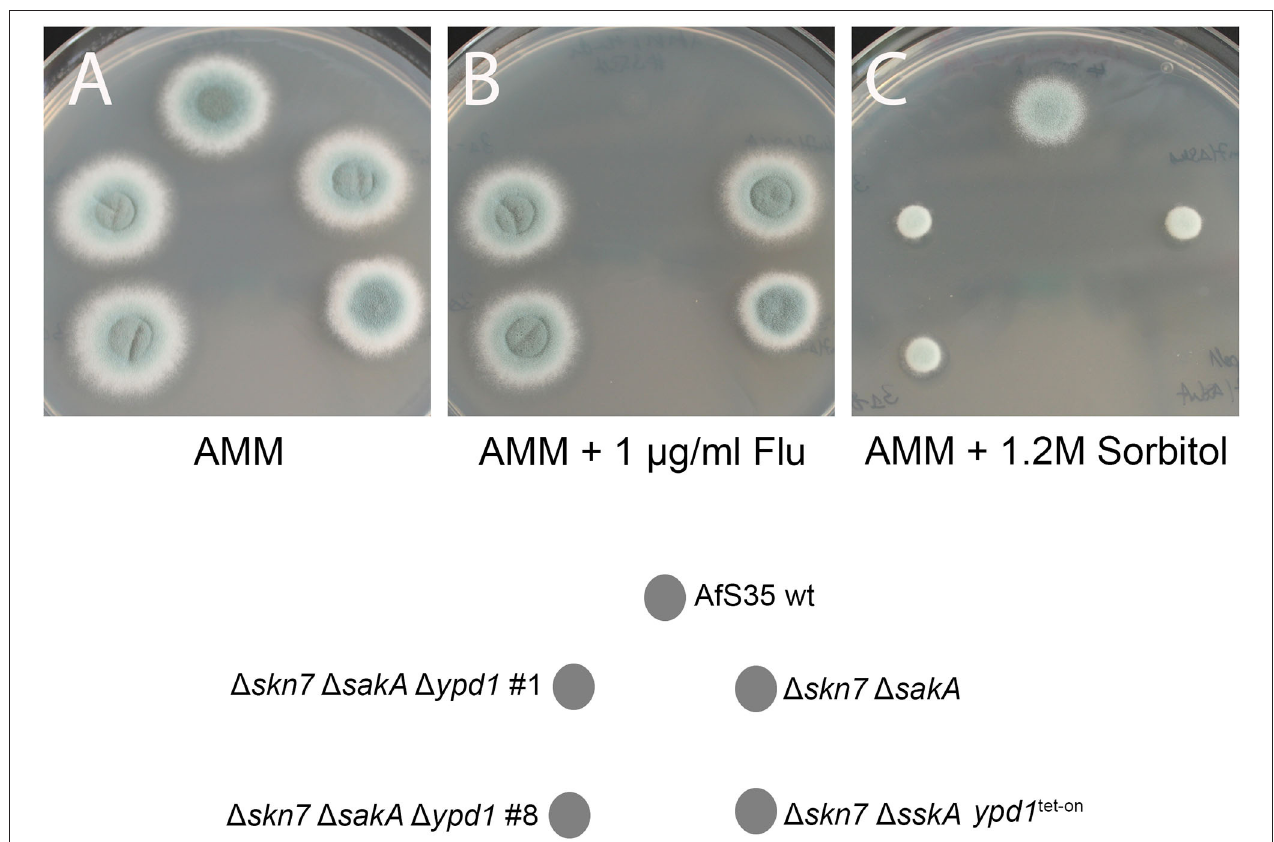
FIGURE 6 | Two independent clones of the 1 ypd 1 1 sak A 1 skn 7 triple mutant (#1 and #8) show a normal growth on AMM plates (A) . As its parental strain 1 sak A 1 skn 7, the triple mutants are resistant to fludioxonil (B) and sensitive to hyperosmotic stress (1.2M sorbitol; C ). The 1 skn 7 1 ssk A ypd 1 tet − on strain was also analyzed for